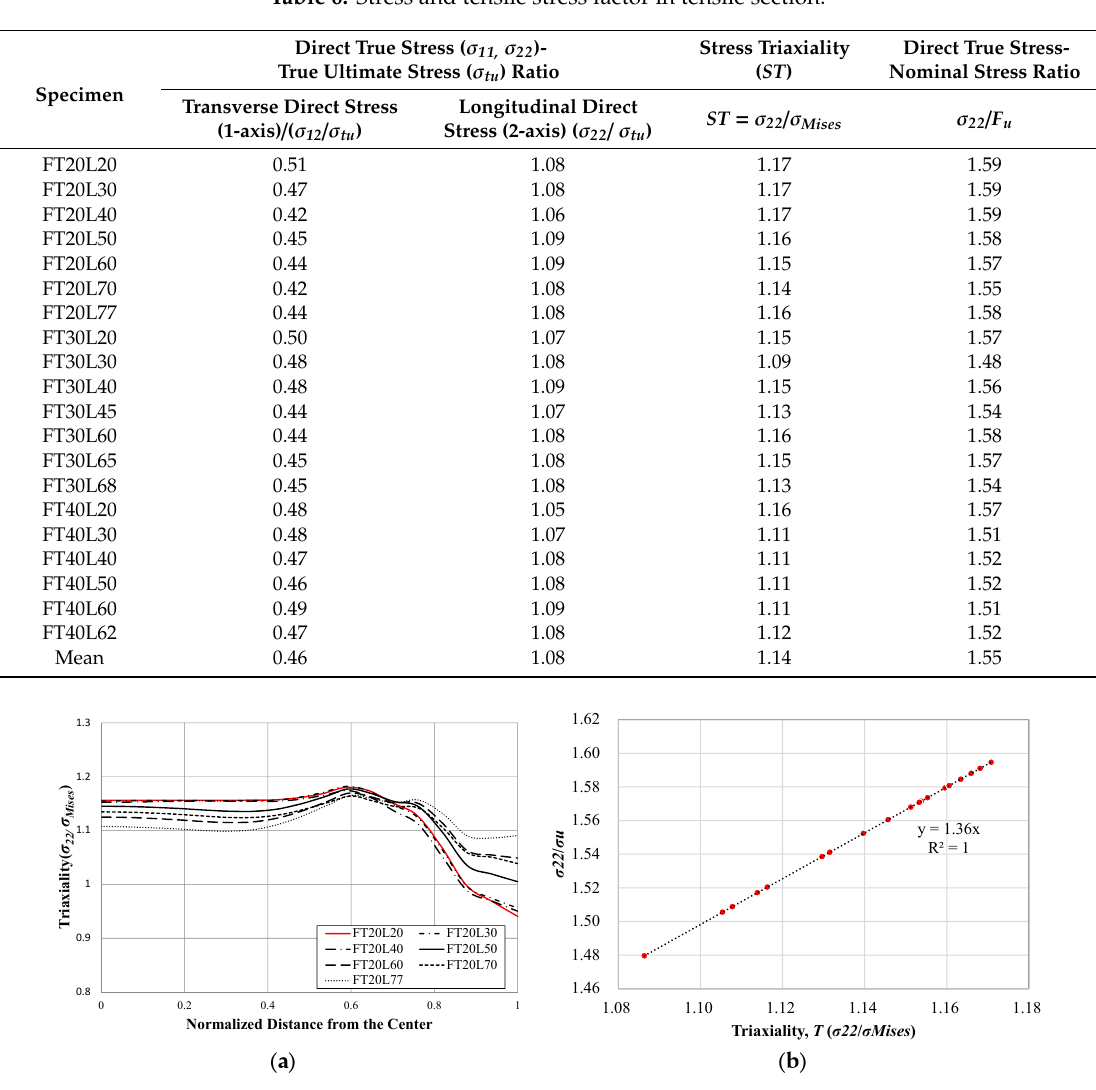
Figure 10. Triaxiality ( T ) and normalized maximum longitudinal stress ( σ 22/ σ u ) from the toe of the weld line on the tension plane (Path 3): ( a ) Triaxiality ( T ), ( b ) Relationship between triaxiality ( T ) and normalized maximum longitudinal stress ratio ( σ 22/ σ u ). Table 6. Stress and tensile stress factor in tensile section.